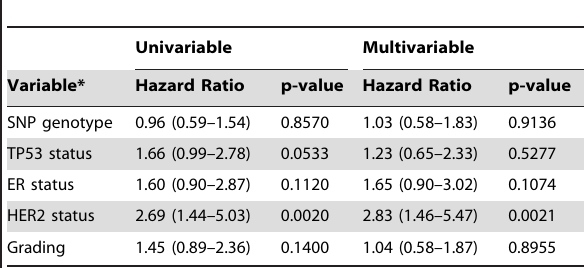
Table 5. Univariable and multivariable analyses of the disease-free survival using a Cox proportional hazards